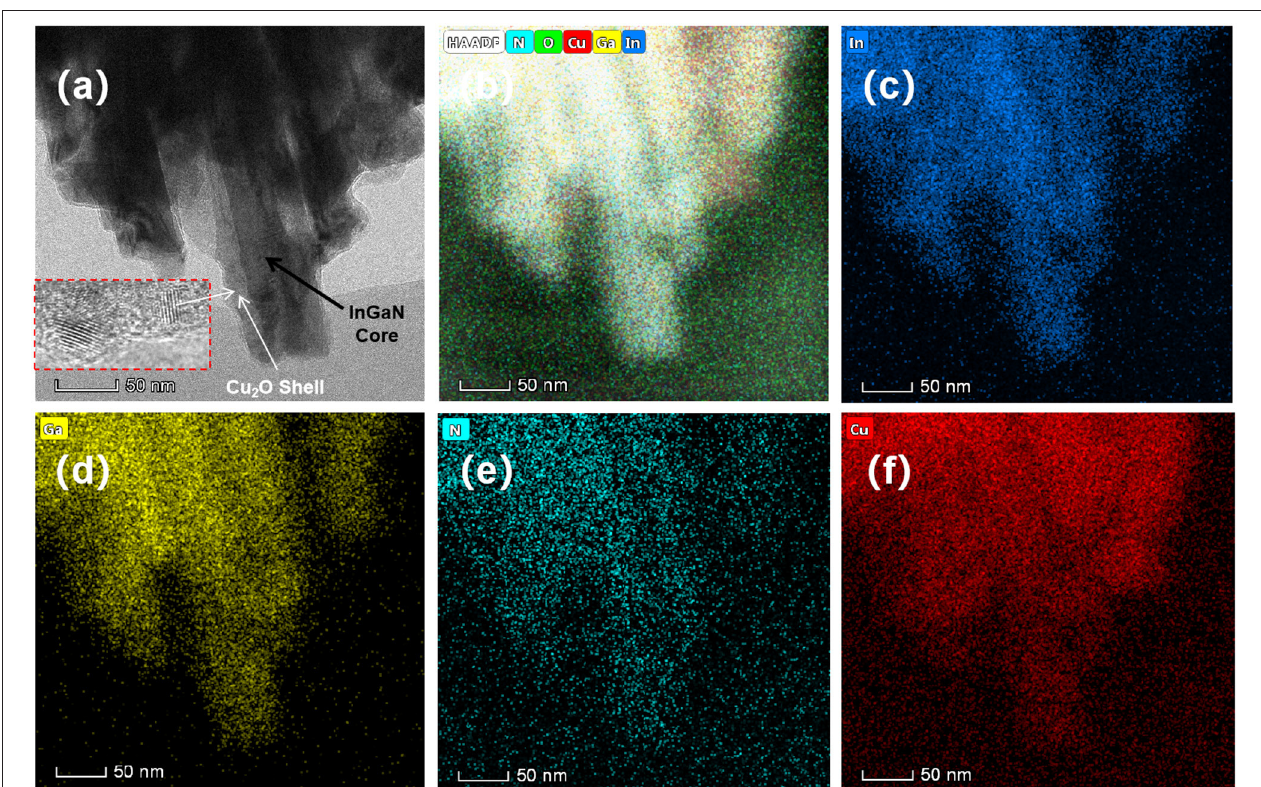
FIGURE 3 | (a) Cross-sectional TEM image and (b–f) EDS element mappings. (b) Total EDS intensity and (c–f) In, Ga, N, and Cu element mappings. The inset in (a) is a high-resolution TEM image of the Cu 2 O